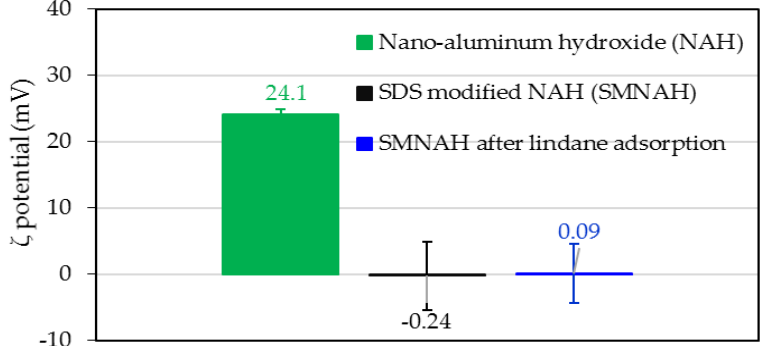
Figure 11. The ζ potential of synthesized nano-aluminum hydroxide (NAH), SDS-modified nano-aluminum hydroxide (SMNAH) and SMNAH after lindane adsorption in 10 mM NaCl (pH 6.0).